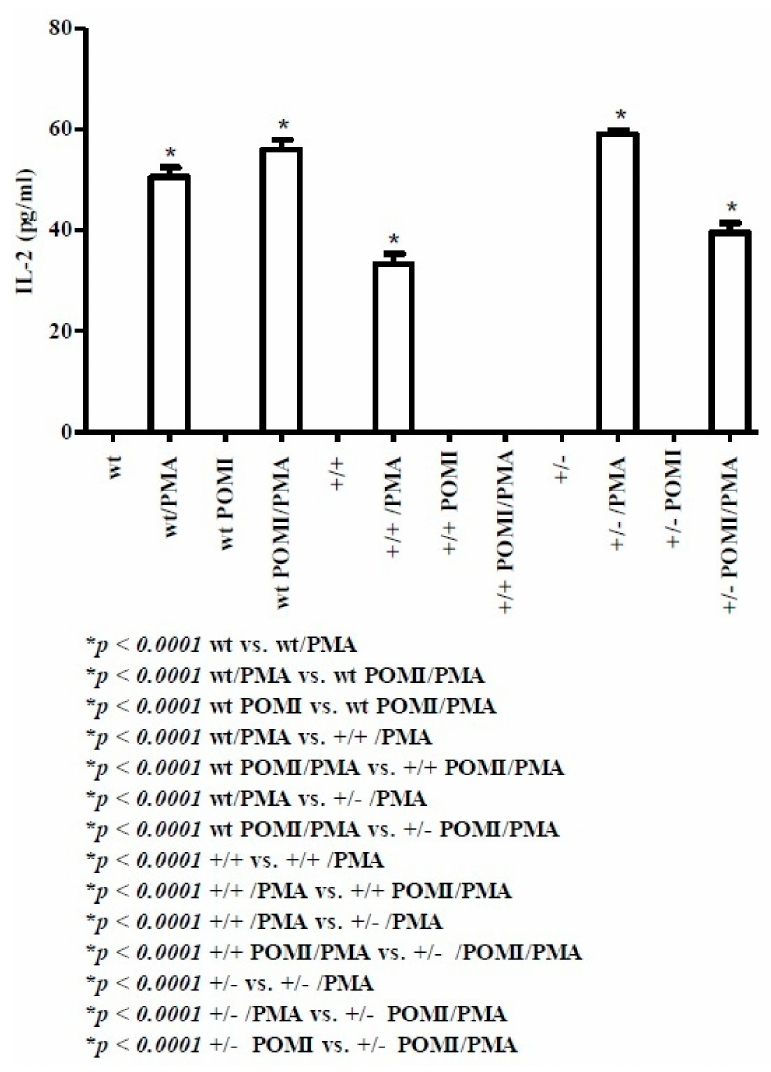
Figure 2. Levels of IL-2 in splenic supernatants from cell cultures of mice at day 30. Abbreviations: wt = wild type; +/+ = homo, +/ − = hetero; POMI: post-weaning mice that received conventional feed supplemented with polyphenols. For methods and statistical analysis, see Figure